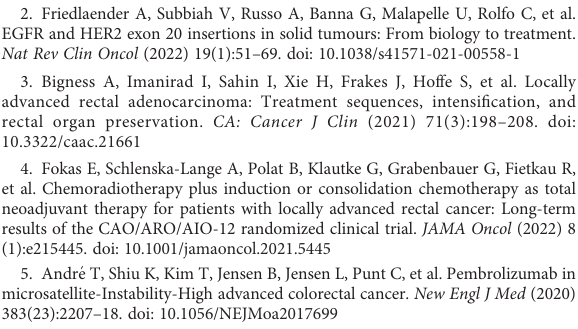
SUPPLEMENTARY FIGURE 4 Tumor-in fi ltrating T cells exhibit molecular heterogeneity according to tumor sideness and KRAS/TP53 mutation status. ( A, B ) The UMAP plots demonstrated the distribution of 16 kind of T-cell subtypes according to tissue origin (A) and tumor sideness (B) . (C) The GSEA analysis of DGEs demonstrated the differently enriched pathways of T cells in left- and right-sided colorectal cancers. (D) The UMAP plots demonstrated the distribution tumor-in fi ltrating T-cell subtypes according to KRAS/TP53 mutation status. (E) he GSEA analysis of DGEs demonstrated the differently enriched pathways of tumor-in fi ltrating T cells according to KRAS/TP53 mutation status. SUPPLEMENTARY FIGURE 5 Identify the myeloid-cell subtypes in normal mucosa, tumor adjacent and tumor tissues. (A) Heatmap depicted the top differentially expressed marker genes across they myeloid cell types. For each group, a maximum of 500 cells were randomly selected to draw the heatmap. (B) Theheatmappresentedtheproportionof10myeloid-celltypesacross different samples. (C) The t-SNE plots demonstrated the distribution of 10 myeloid-cell subtypes according to tumor sideness. SUPPLEMENTARY FIGURE 6 Survival analyses identi fi ed the prognostic value of immune-in fi ltration score of 59 immune cells according to the KRAS/TP53 mutation status. (A – D) represented the statistically signi fi cant immune-in fi